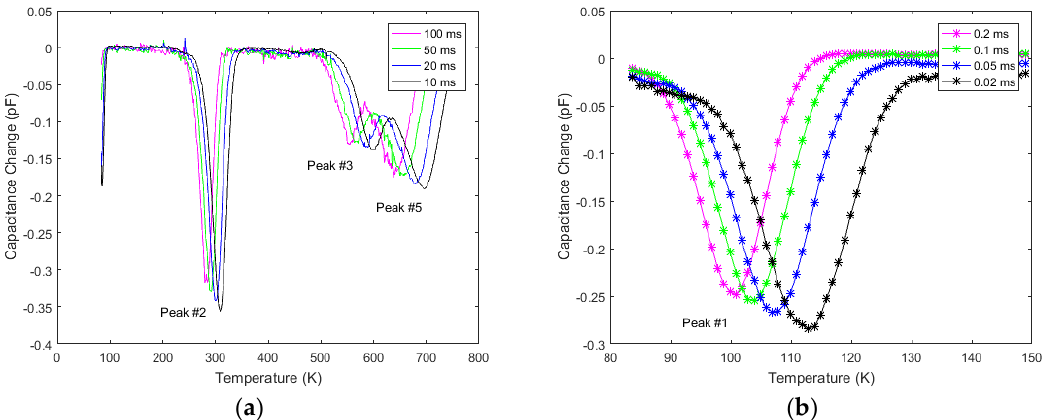
Figure 22. DLTS spectra of the detector obtained using the highest ( a ) and lowest ( b ) sets of initial delays over the temperature range of 84–750 K.